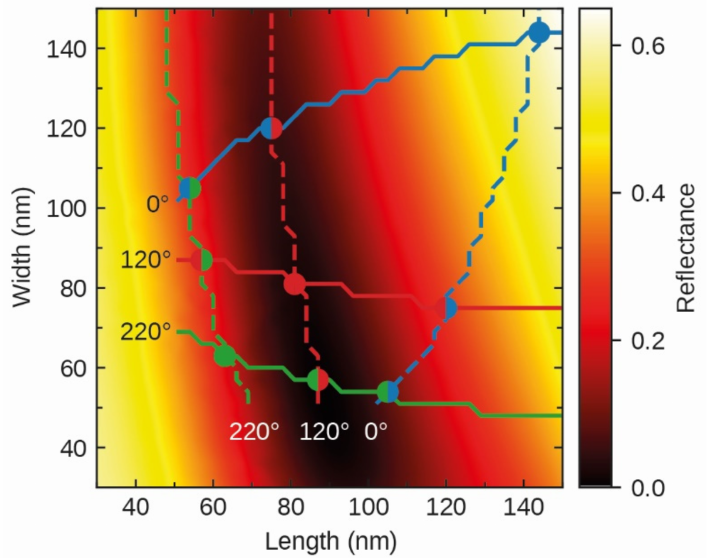
Figure A4. Reflectance amplitude at 500 nm in color for different nanobrick widths and lengths. The phase response isolines for x- and y-polarized light at 0, 120 ◦ , and 220 ◦ degrees are marked with solid and dashed lines, respectively. The parameters of the bricks at the crossing points marked with dots were used for the supercell